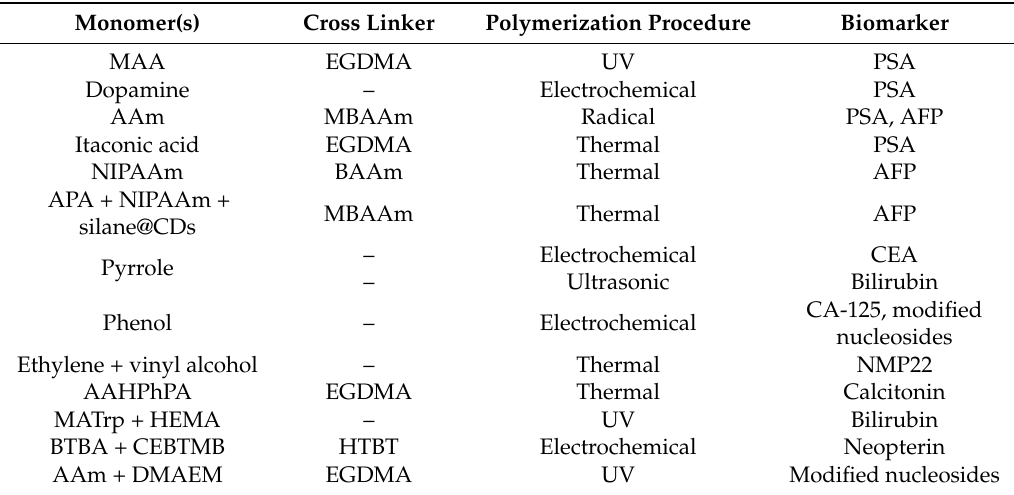
Table 2. Most common monomers and polymerization procedure applied in MIP-based sensors for cancer biomarker analysis. Monomer(s) Cross Linker Polymerization Procedure